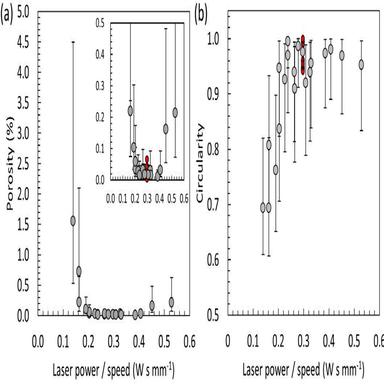
(a) Mean percent porosity versus the ratio of laser power to scan speed with an inset rescaled to better show low porosity data points (b) Mean pore circularity versus the ratio of laser power to scan speed. Porosity (area fraction) was determined by one micrograph per column on two different combinatorial samples. See for a description of the interval calculations. Smaller, red data points are the five columns at the default settings. (For interpretation of the references to color in this figur